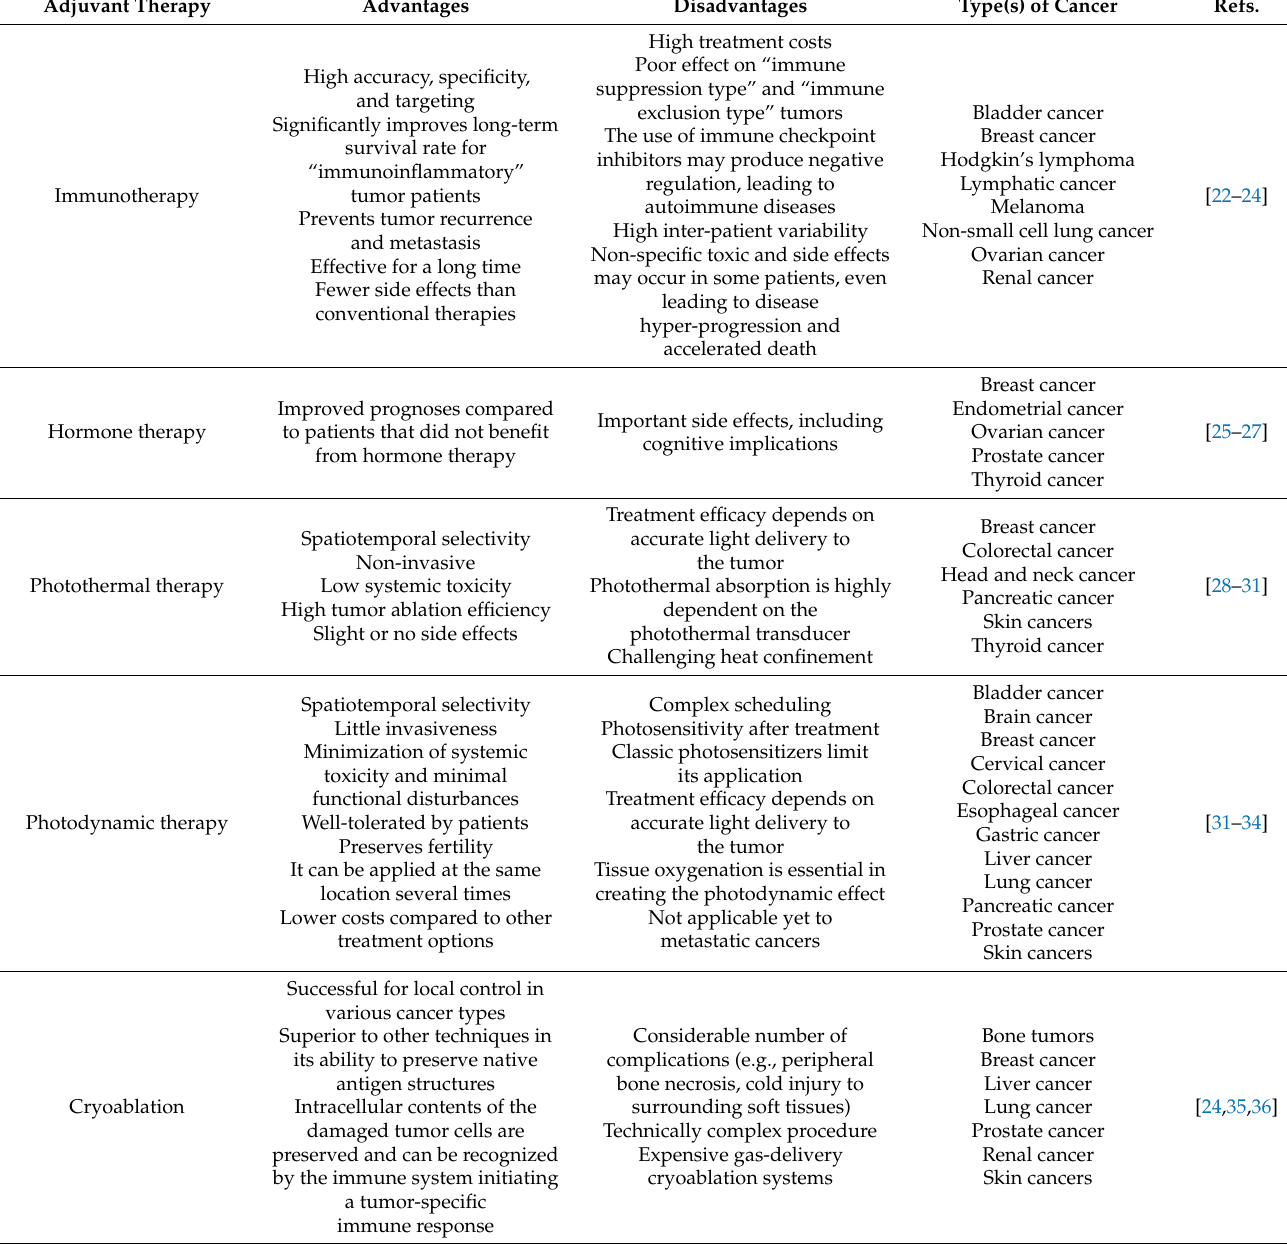
Table 1. Summary of adjuvant therapies used in various types of